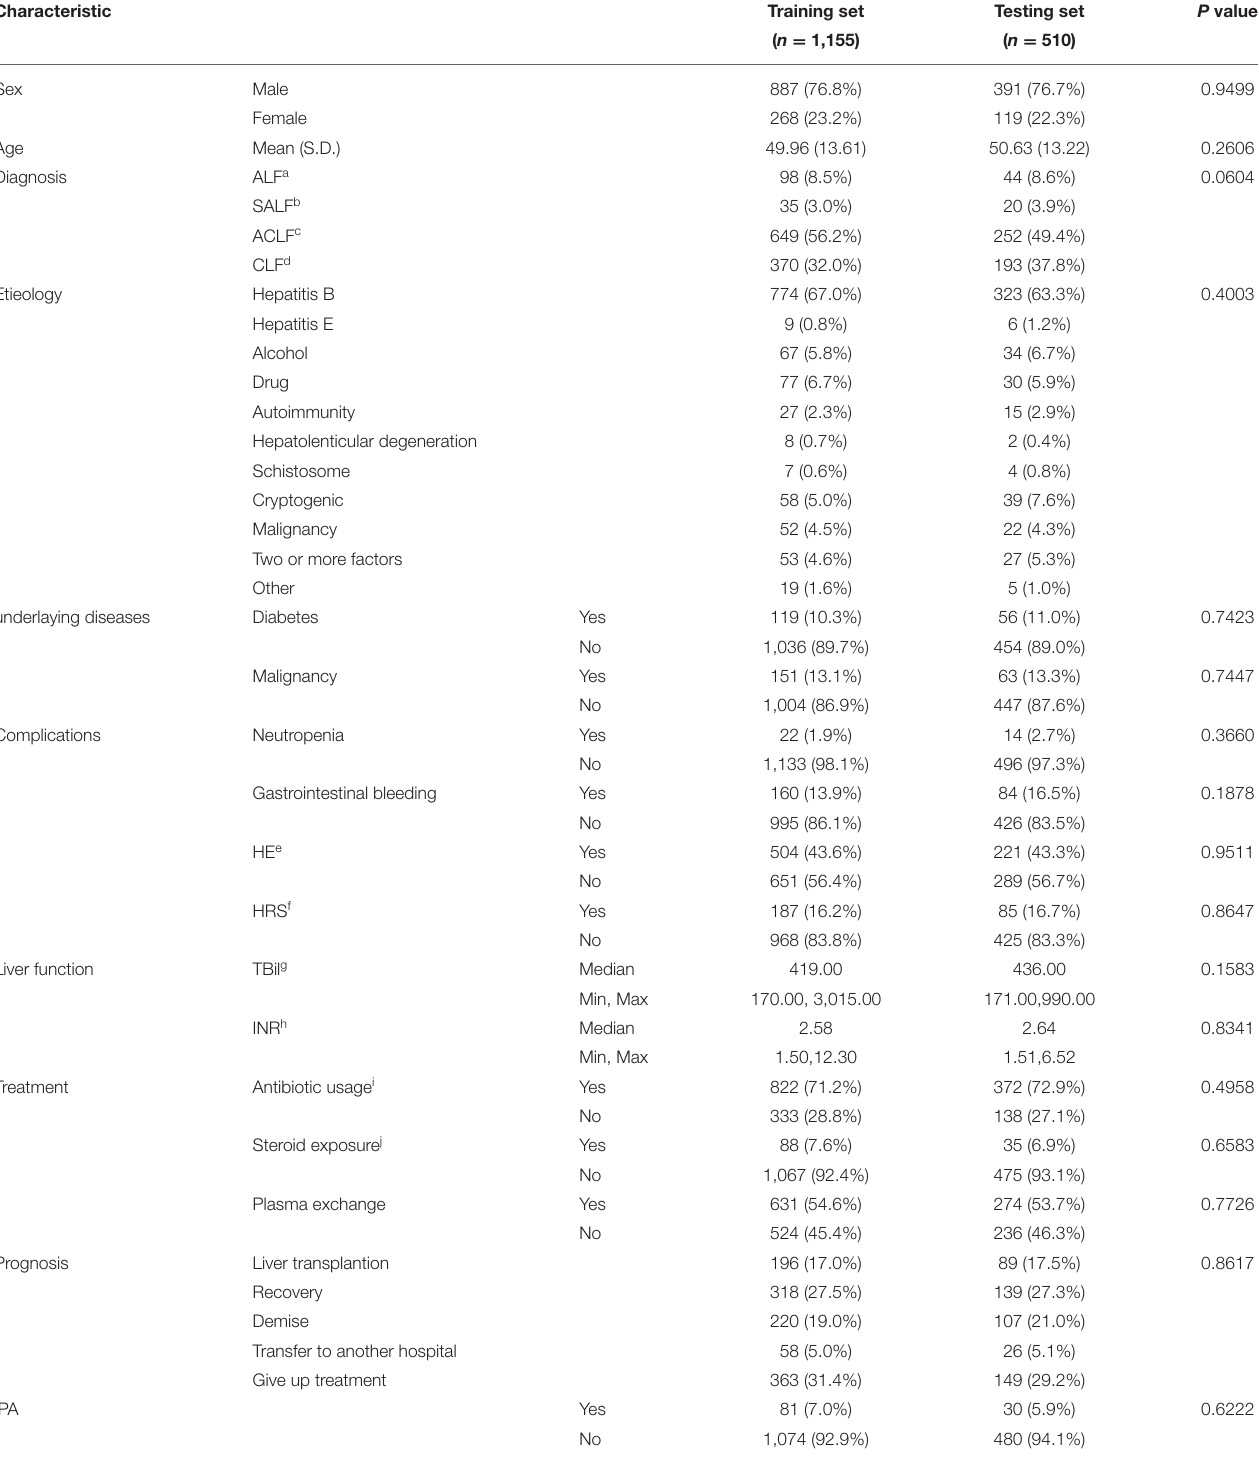
TABLE 1 | Characteristics of patients with liver failure in the training and testing sets. Characteristic Training